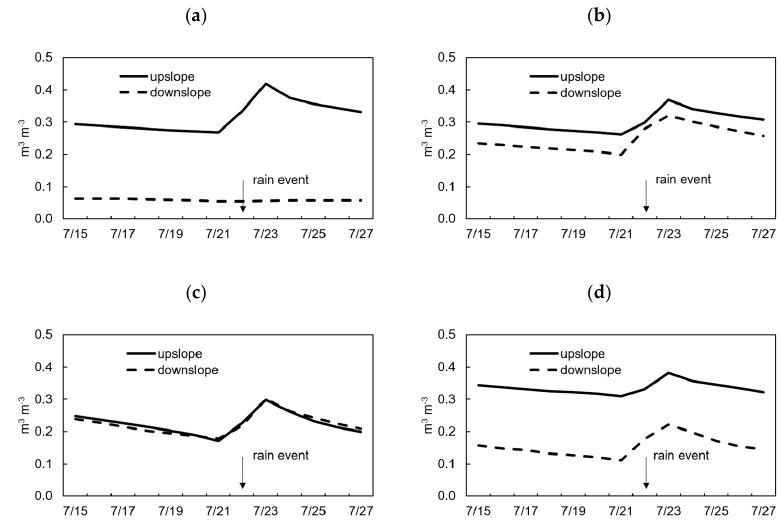
Figure 7. Soil moisture content (m 3 m − 3 ) at 5 cm soil depth upslope and downslope of individual Ch. obtusa trees ( a ), individual Cr. japonica trees ( b ), individual Ch. obtusa stumps ( c ) and individual Cr. japonica stumps ( d ). Down arrows indicate the rain event on 22 July.